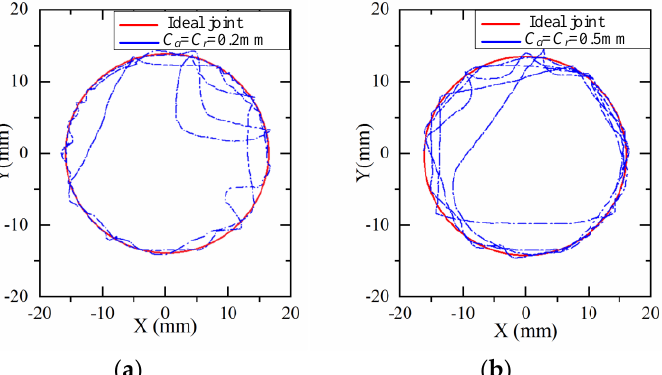
Figure 12. The path track of the journal center inside the bearing: ( a ) the center trajectory of the journal when both clearances are 0.2 mm and ( b ) the center trajectory of the journal when both clearances are 0.5 mm.